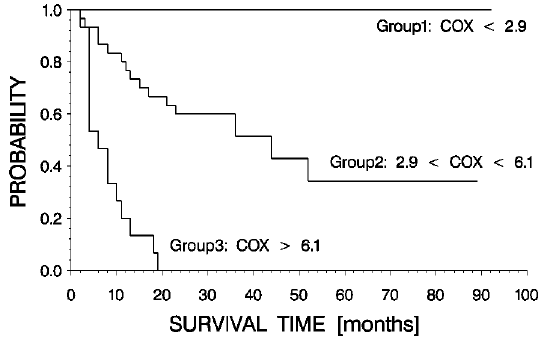
Fig. 5. Kaplan–Meier survival curves for three patient groups ac- cording to the Cox regression analysis.